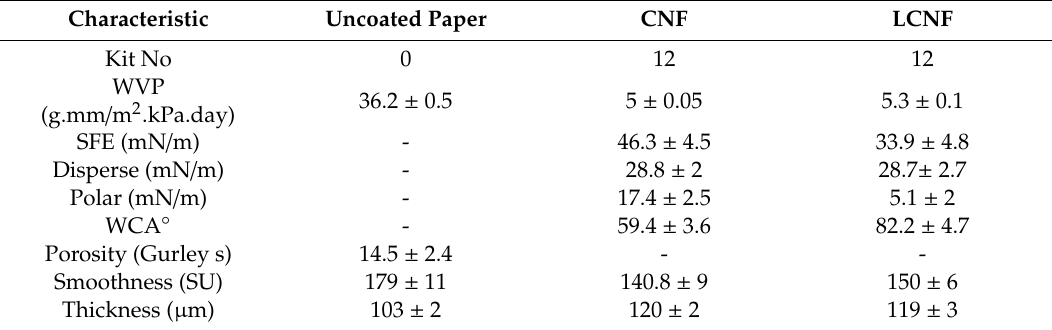
Table 3. Grease resistance (kit number), water vapor permeability (WVP), surface free energy (SFE), smoothness and water contact angles (WCA) for the paper substrates coated with CNF and LCNF.